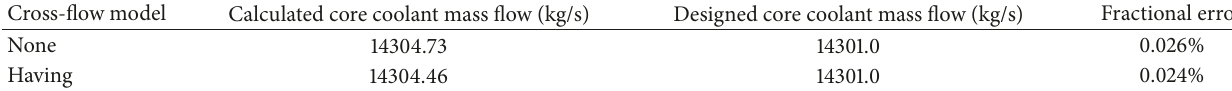
Table 19: The influence of cross-flow model on the core coolant mass flow.